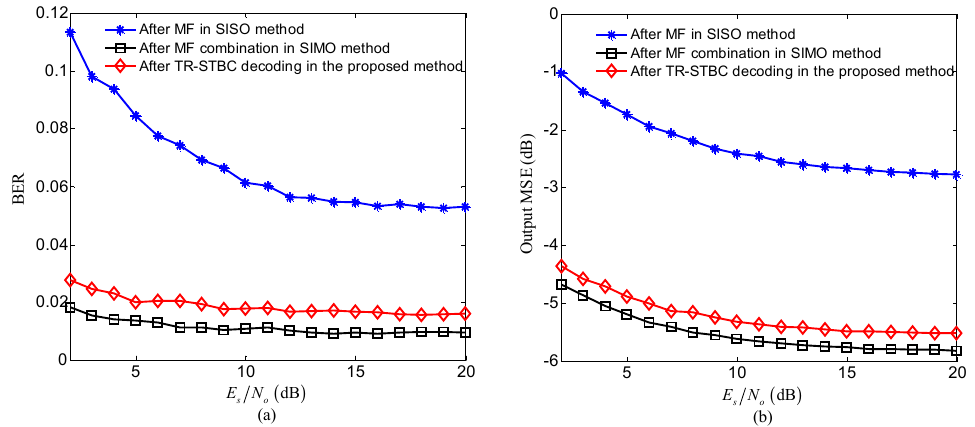
Figure 7. Comparison of the performance after three processing scenarios consisting of time-reversal space-time block coding (TR-STBC) decoding in the proposed method, matched filtering (MF) in the SISO method and MF combination in the SIMO method: ( a ) bit error rate (BER); ( b ) output mean square error (MSE).